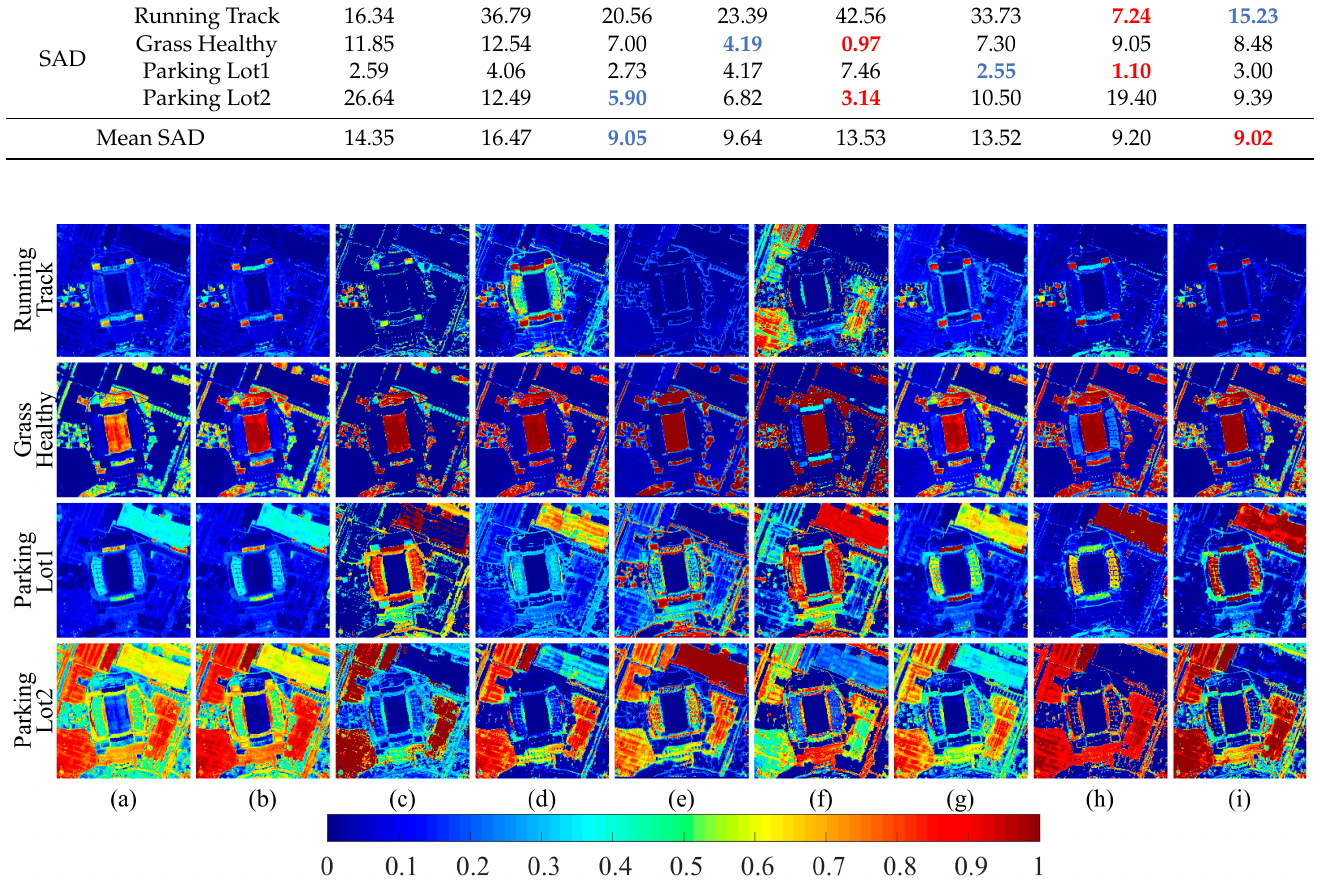
Figure 16. Visualization results of the endmembers of Houston data. ( a ) VCA-FCLS. ( b ) SGCNMF. ( c ) DAEU. ( d ) MTAEU. ( e ) CNNAEU. ( f ) CyCU-Net. ( g ) MiSiCNet. ( h ) SSANet. 4.3.5. Experiments with Urban Data Tables 8 and 9 show the quantitative metric comparisons for the Urban dataset. Fig- ures 17 and 18 visualize the results of the abundances and endmembers, respectively. A feature of this dataset is its complex distribution, and mixed pixels are broadly distributed in this scene. It is worth noting that SSANet had the fi nest mean and individual RMSE, and the mean RMSE was 11% lower than that of the suboptimal method. Additionally, the